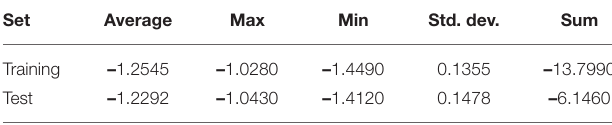
Table 4B | Unicolumn statistics of training and test sets for nematicidal activity against M. incognita .